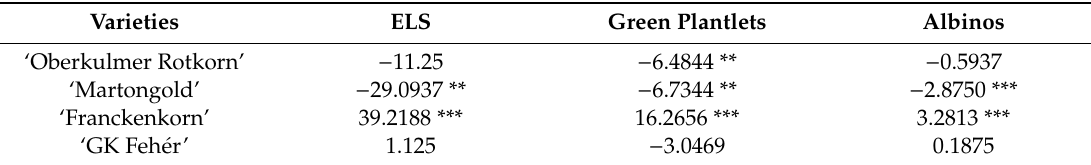
Table 6. General combining ability (GCA) e ff ects for ELS, green-, and albino plantlets in a full diallel spelt population. Varieties ELS Green Plantlets Albinos ‘Oberkulmer Rotkorn’